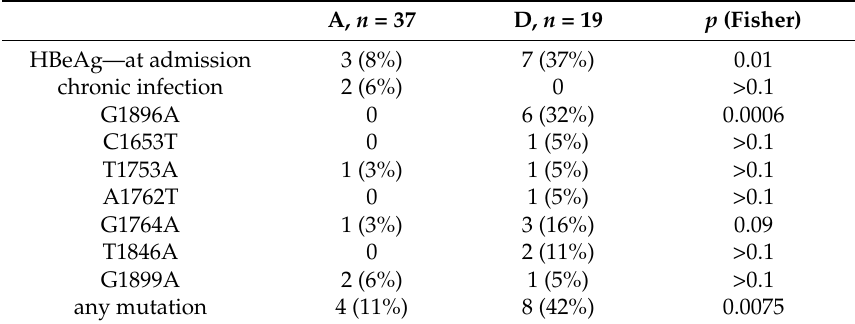
Table 3. Prevalence of HBeAg positivity, incidence of chronification and prevalence of BCP/precore mutations in genotype AHB patients infected with genotype A or D